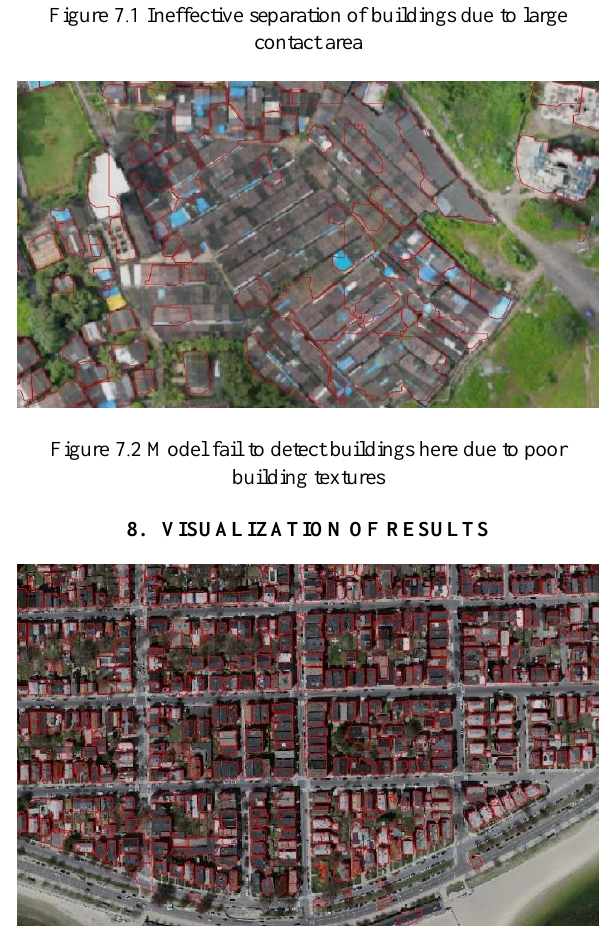
Figure 8 . 1 Dataset from Boston ( Mnih, 2013 ) Structured building dataset taken from Satellite of Boston Area . Resolution of the image is 30cm